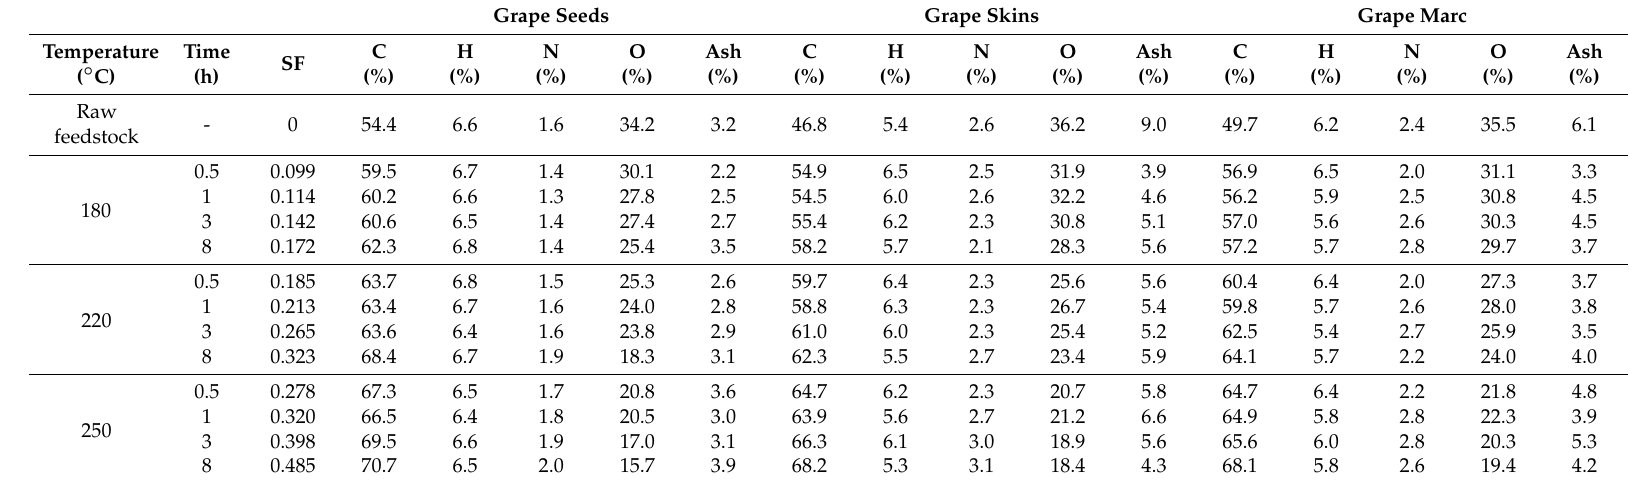
Table 1. Elemental analysis of the raw feedstocks and of the hydrochars obtained at different process conditions. Grape Seeds Grape Skins Grape